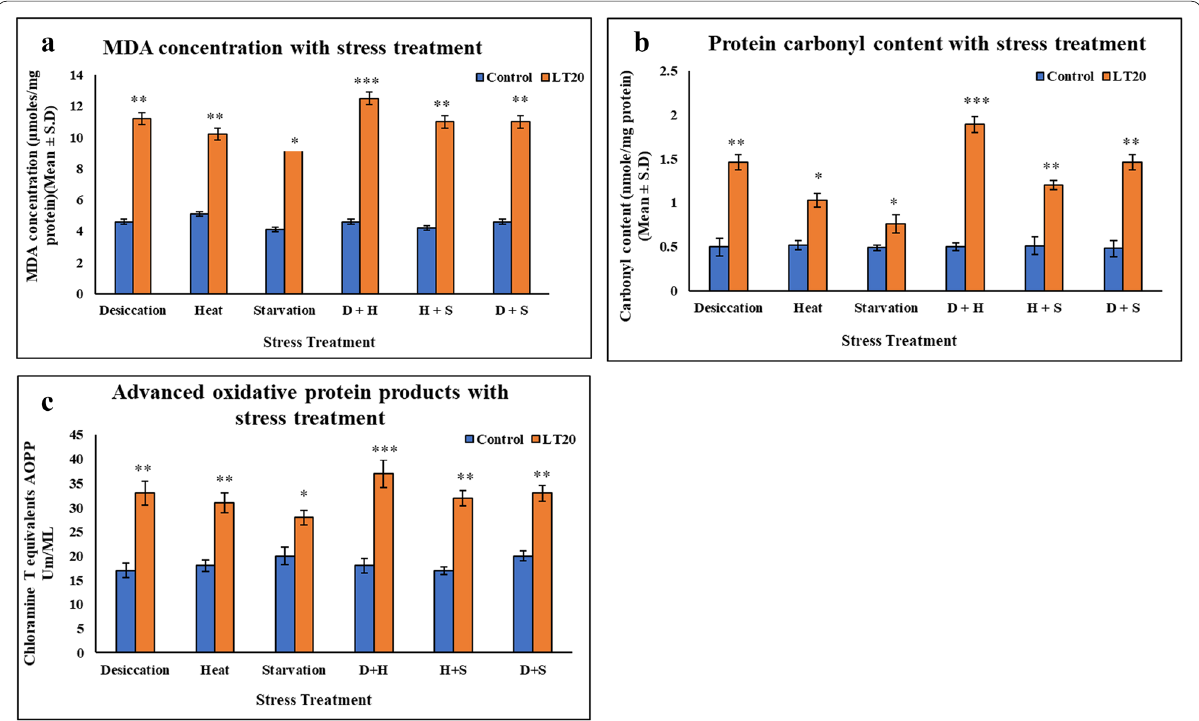
Fig. 1 Impact of oxidative stress: Spectrophotometric measurement of a Lipid peroxidation (mean concentration with stress treatment. b Protein carbonyl content (mean (mean SD U/mL) in fourth instar larvae of C. ramosus . Values represent mean and the vertical bars represent SD. Data shown are representative of ± three independent experiments. ***P < 0.001; **P < 0.01; *P < 0.05 indicates level of